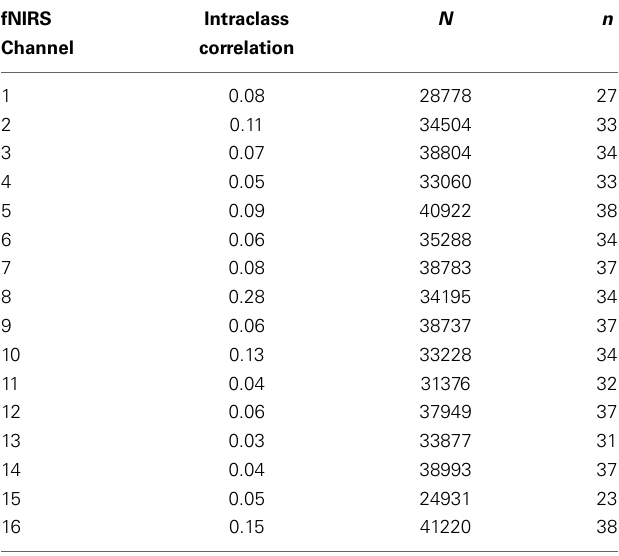
Table 2 | Descriptive statistics for oxy-Hb time-series across fNIRS channels.